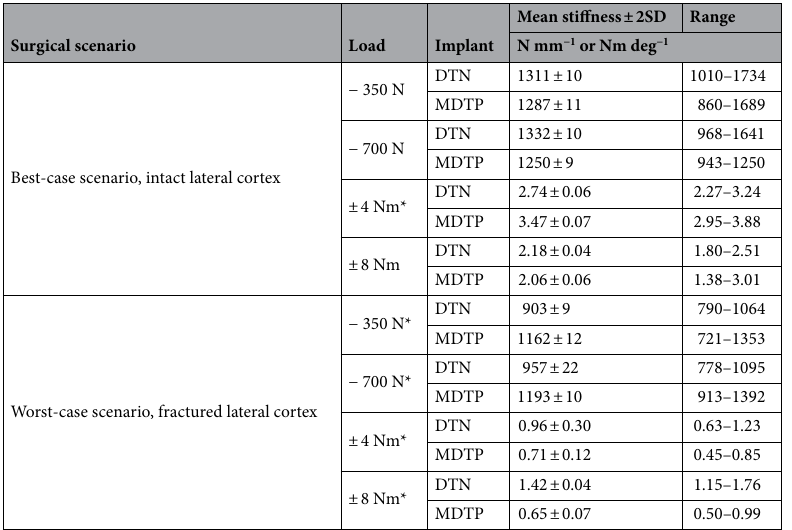
Table 1. Average compression and torsional construct stiffness ± two standard deviations for all samples based on applied load and implant. The range is given based on minimum to maximum construct stiffness. SD, standard deviation. *Significant difference at the 95% level between the DTN and MDTP implant